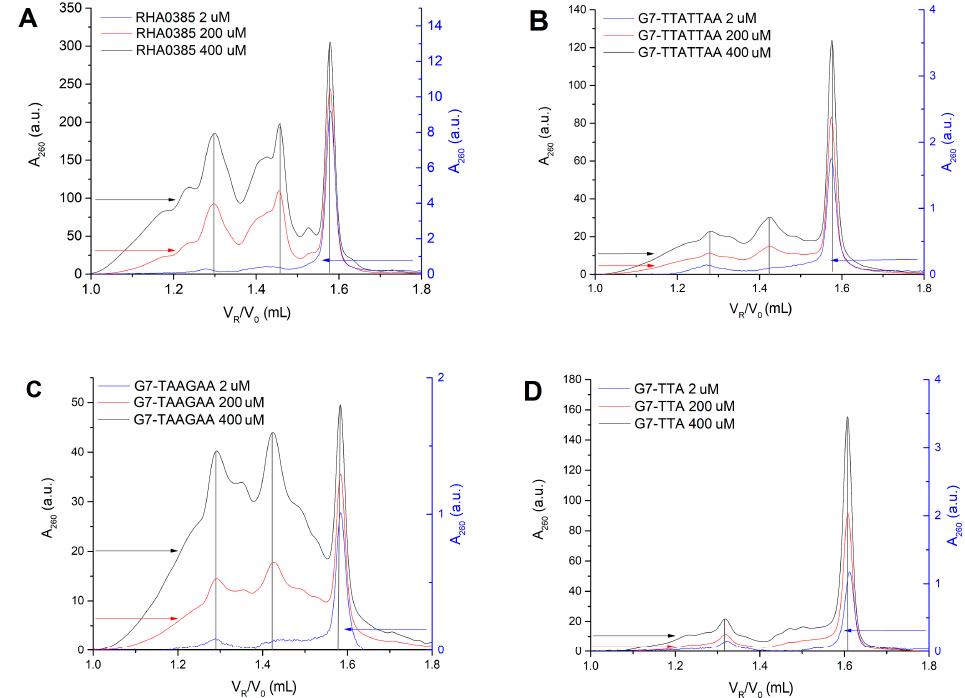
Figure 5. Chromatograms of size-exclusion high performance liquid chromatography SE-HPLC for the 2, 200, 400 µM solutions of ( A ) RHA0385, ( B ) G7-TTATTAA, ( C ) G7-TAAGAA, ( D ) G7-TTA demonstrate different content of mono- and oligomeric forms in solutions of different aptamers. The right Y axis refers to the 2 µM sample, the left one—to 200 and 400 µM. The peaks with 0.9, 1.6, and 2.6 ratios between the expected and the experimental molecular weights are observed and labelled by grey lines.